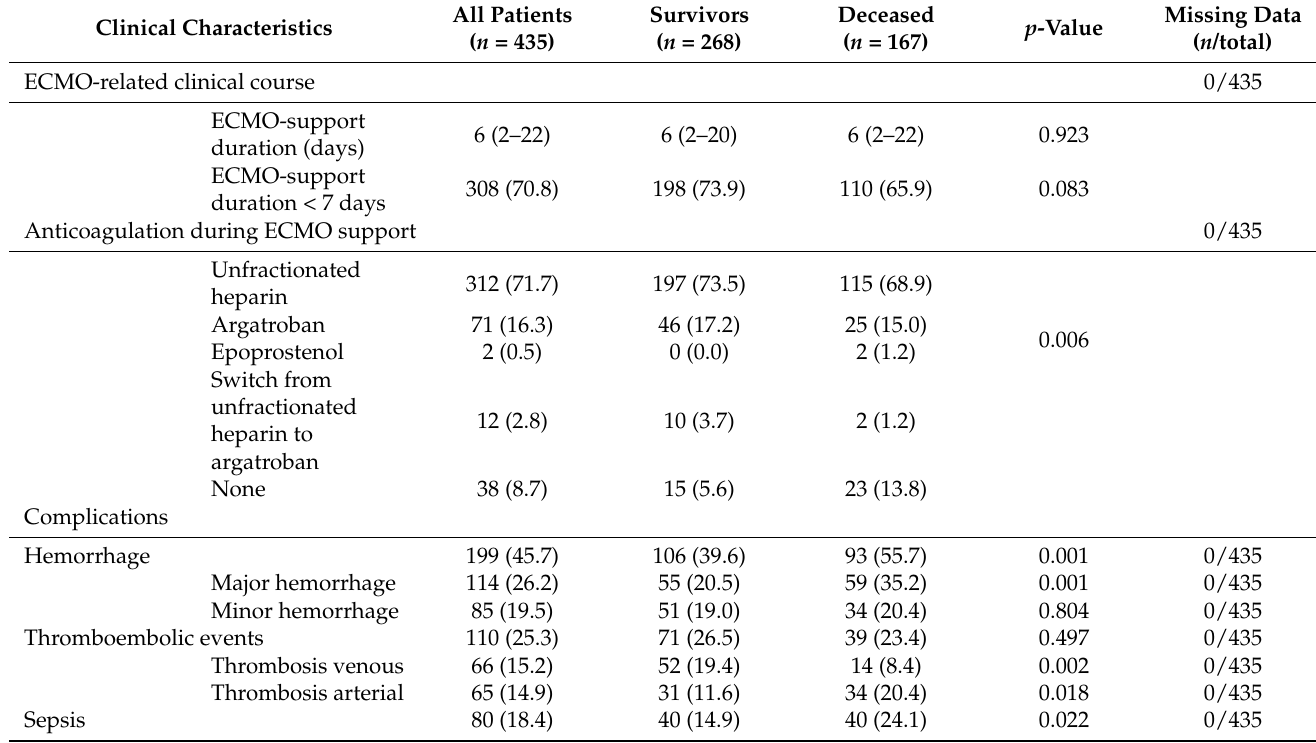
Table 2. ECMO-related characteristics and outcomes ( n =